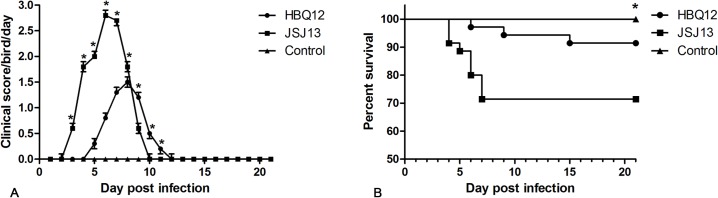
Clinical scores (A) and survival rates (B) of chickens after inoculation with FAdV HBQ12 or JSJ13 strain.Clinical scoring: 0 for normal, 1 for mild depression, 2 for severe depressed, 3 for paralysis/prostration, and 4 for death. The mean scores per group per day are shown. The error bars indicate standard deviations. Asterisks (*) mark the days in which the clinical scores were significantly different between groups (P <0.05). The percentage of birds that survived in the infected groups were significantly lower than in the control group (P <0.05, log rank analysis).